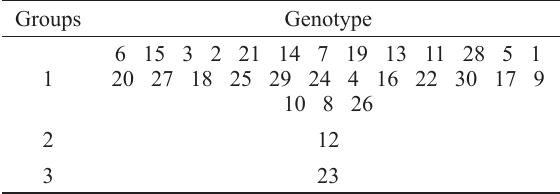
Clusters formed from 30 promising registered Coffea canephora genotypes, obtained by Tocher’s method, based on generalized Mahalanobis distance (D 2 ), considering 15 morpho-agronomic traits. Vila Valério - ES, Brazil. Groups